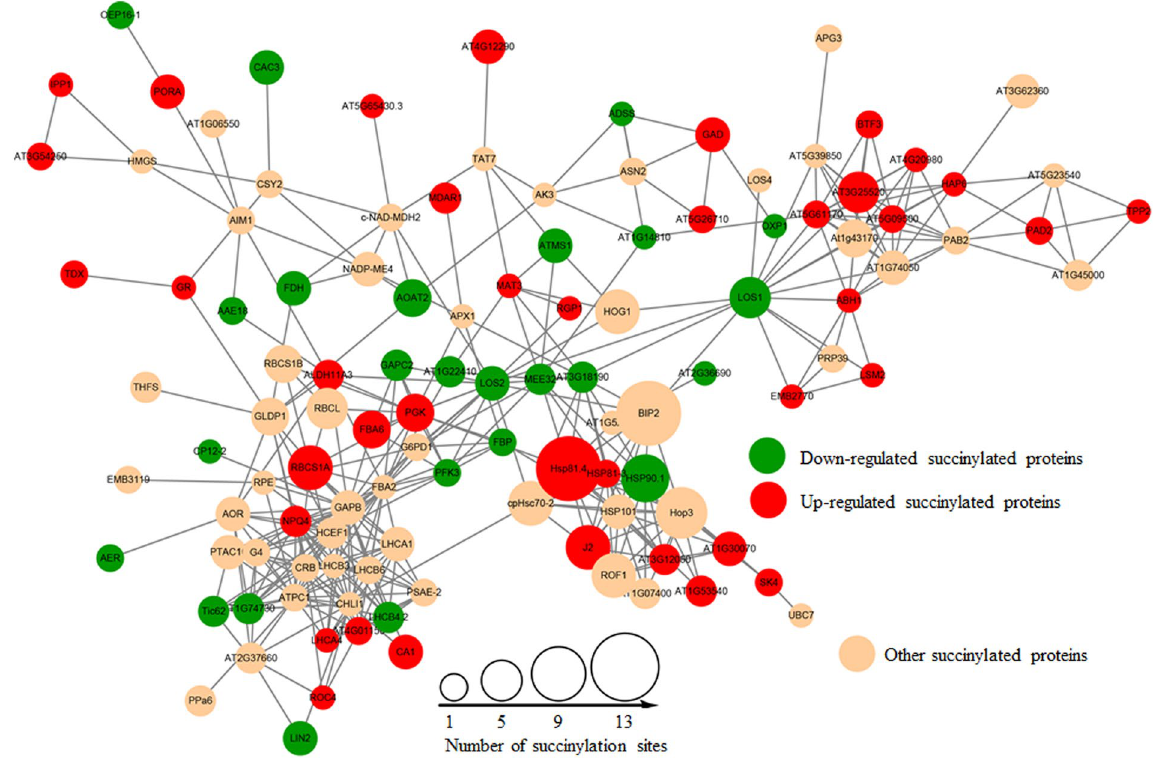
Figure 8. PDSL protein-protein interaction maps in